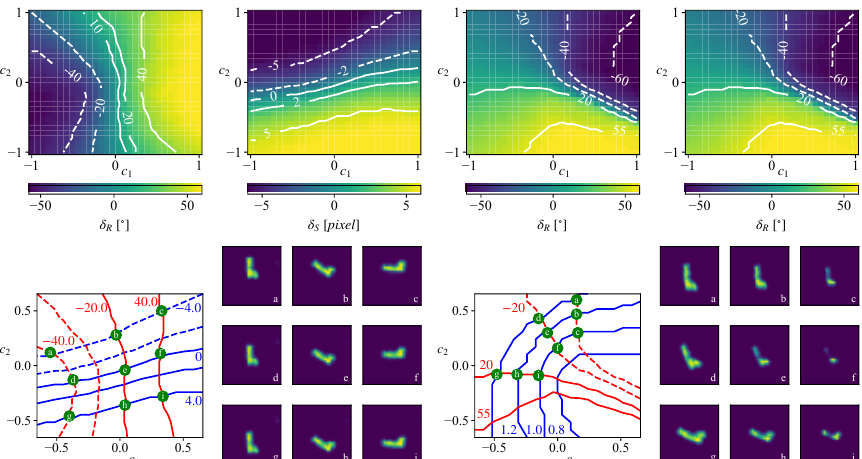
Figure 11. The relation between rotation–translation and two latent codes. The relation between rotation angle δ R and c 1 , c 2 ( top-left ). The relation between translation δ S and c 1 , c 2 ( top-right ). The overlapped curves of the above two contours as well as some selected intersections (green dots) ( bottom-left ). The synthesized SAR images with ( c 1 , c 2 ) corresponding to the coordinates of the green dots in the former contour ( bottom-right ). Here nine collocations of c 1 and c 2 are selected and labeled as a, b, c, d, e, f, g, h, and i in contour maps.